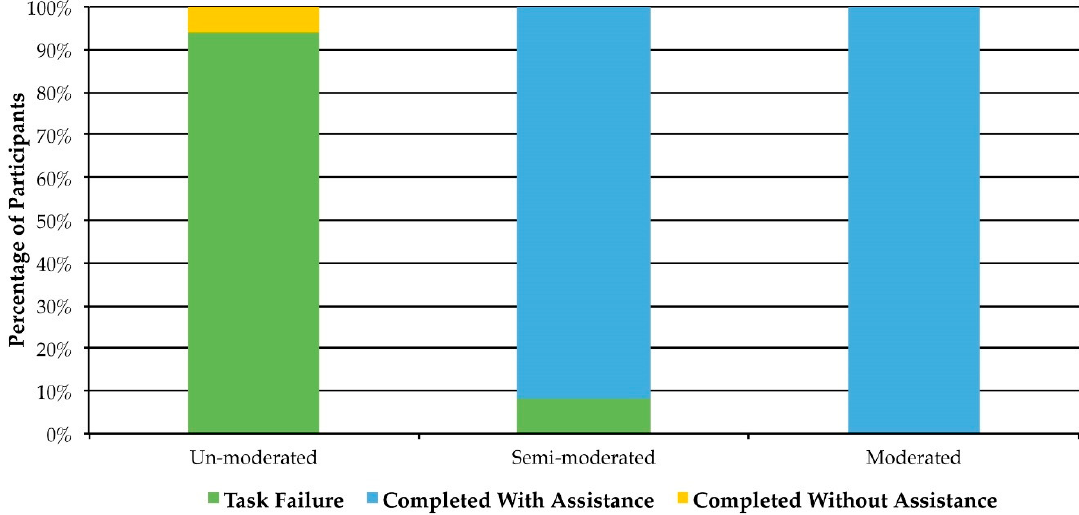
Figure 2. Task success rates for the three groups: unmoderated ( n = 17), semi-moderated ( n = 12), and moderated ( n = 10).